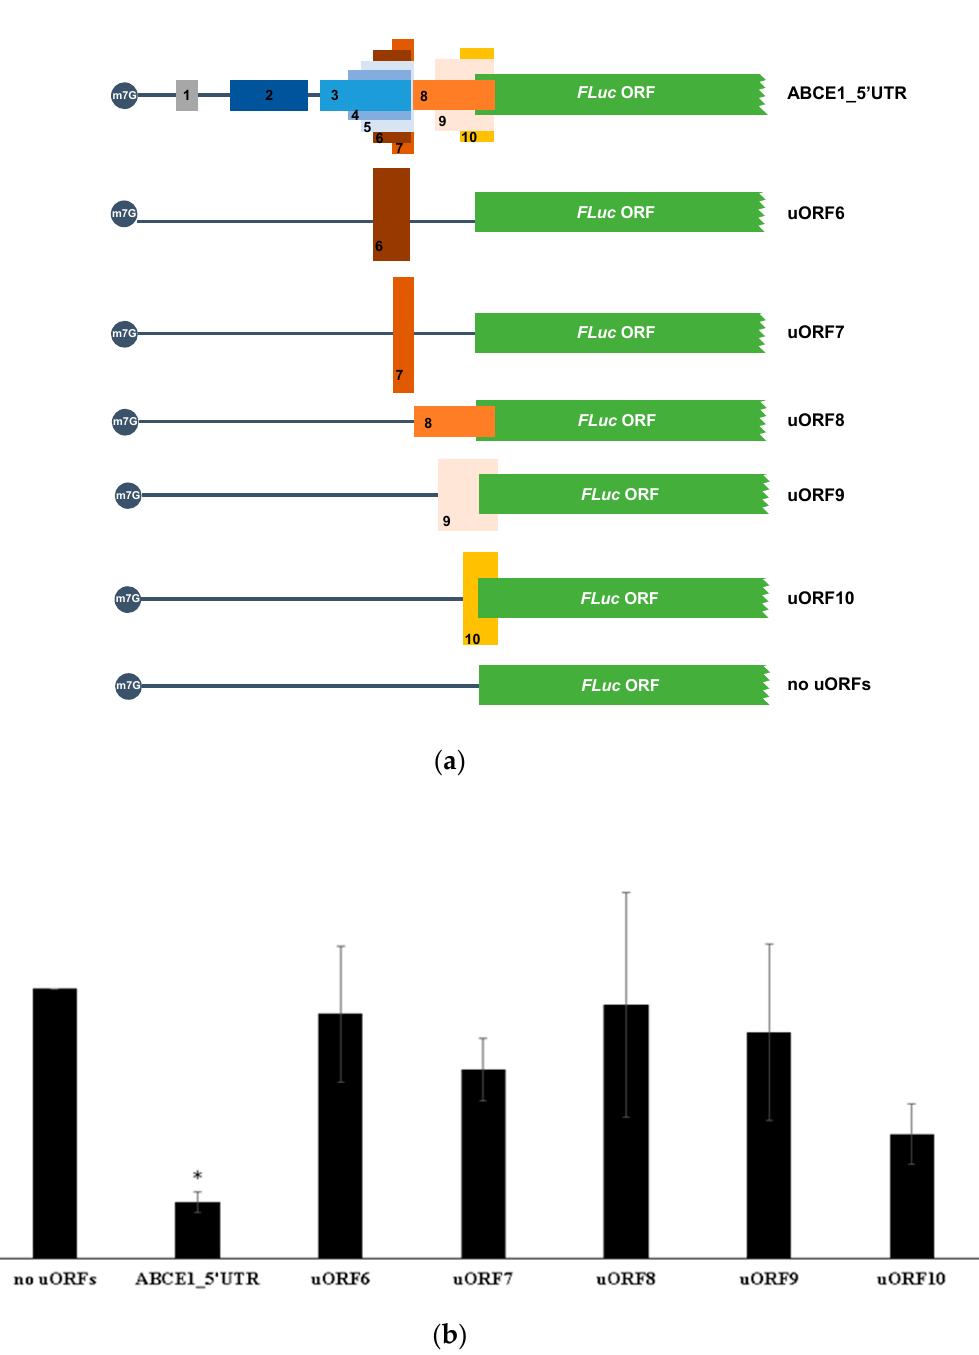
Figure 3. The non-AUG uORFs within the ABCE1 mRNA 5 (cid:48) -leader sequence do not seem to significantly repress translation of the main ORF. ( a ) Schematic representation of the constructs used to study the translational regulatory function of the ABCE1 non-AUG uORFs. The ABCE1_5 (cid:48) UTR, containing the intact ABCE1 5 (cid:48) -leader sequence, was already described in Figure 2a. By site-directed mutagenesis and using the “no AUG uORFs” construct as a template, each non-AUG initiation codon was mutated (CTG/GTG → GCG), creating the constructs with only one functional non-AUG uORF (uORF6-10, represented here by small boxes and only by its uORF number, 6 to 10, to simplify the scheme) or without any uORF (called “no uORFs”). ( b ) Expression of each construct was analyzed as described in Figure 2b legend, but using “no uORFs” construct expression data for the comparison analysis. The results are presented as mean ± SEM from at least three independent experiments. Student’s t-test was applied for statistical significance: p < 0.05